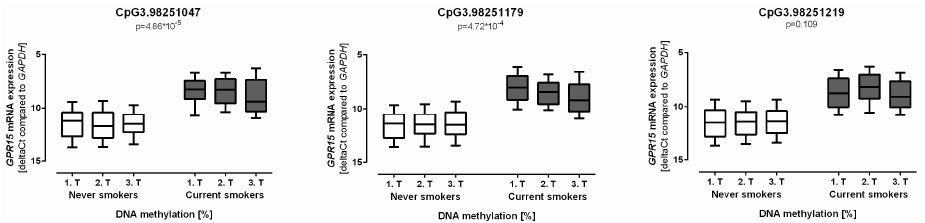
Figure 5. Methylation of G protein-coupled receptor 15 ( GPR15 ) DNA was associated with GPR15 mRNA expression. DNA methylation of CpG3.98251047 and CpG3.98251179 significantly correlated with GPR15 mRNA expression. DNA methylation were divided in tertiles (T) to distinguish low, medium, and high DNA methylation levels. Subjects with lower DNA methylation had higher GPR15 mRNA expression levels. n = 32–164, linear mixed regression model adjusted for age and sex with a significance threshold of 0.0083 after Bonferroni correction, Box plot whiskers represent 10–90th percentile. GPR15 mRNA expression is depicted as Δ Ct values normalized to GAPDH mRNA expression. Lower Δ Ct values indicate higher GPR15 mRNA expression.